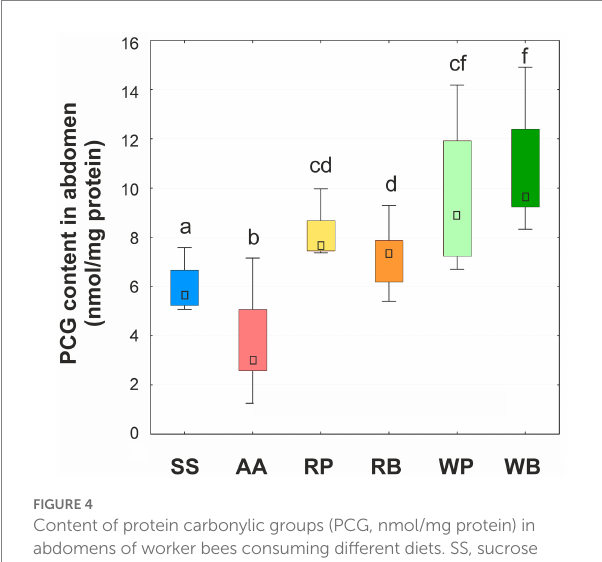
FIGURE 4 Content of protein carbonylic groups (PCG, nmol/mg protein) in abdomens of worker bees consuming different diets. SS, sucrose solution (control group); AA, sucrose solution + amino acids; RP, sucrose solution + rapeseed pollen; RB, sucrose solution + rapeseed beebread; WP, sucrose solution + willow pollen; WB, sucrose solution + willow beebread. Boxes show first and third interquartile ranges with the dot denoting median. Different letters indicate significant differences between the values ( p < 0.05).